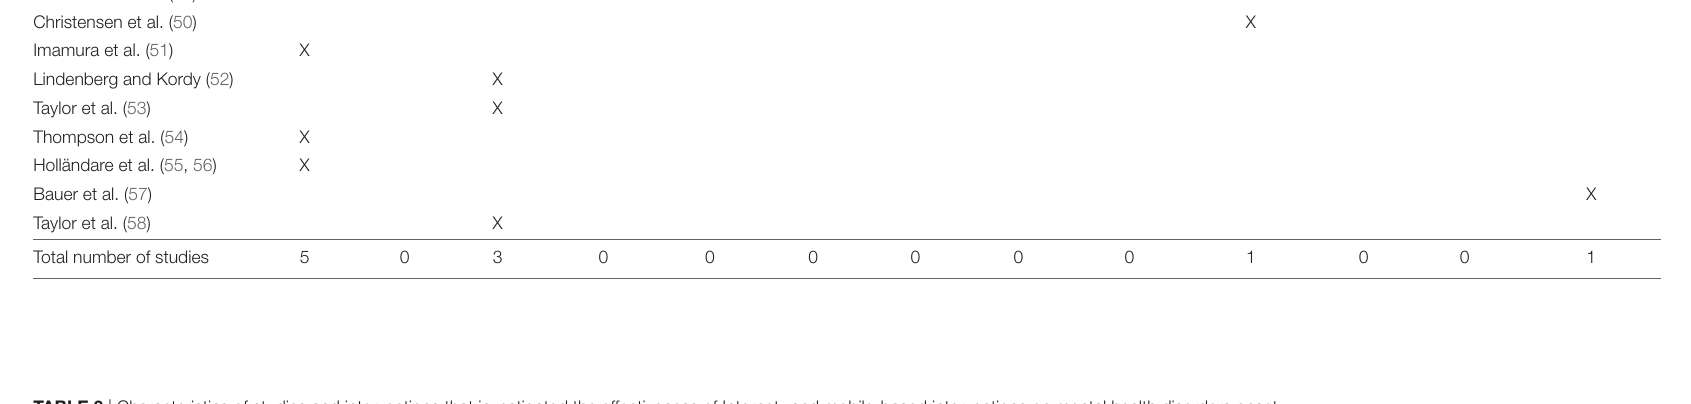
TABle 3 | Characteristics of studies and interventions that investigated the effectiveness of Internet- and mobile-based interventions on mental health disorders onset. Study